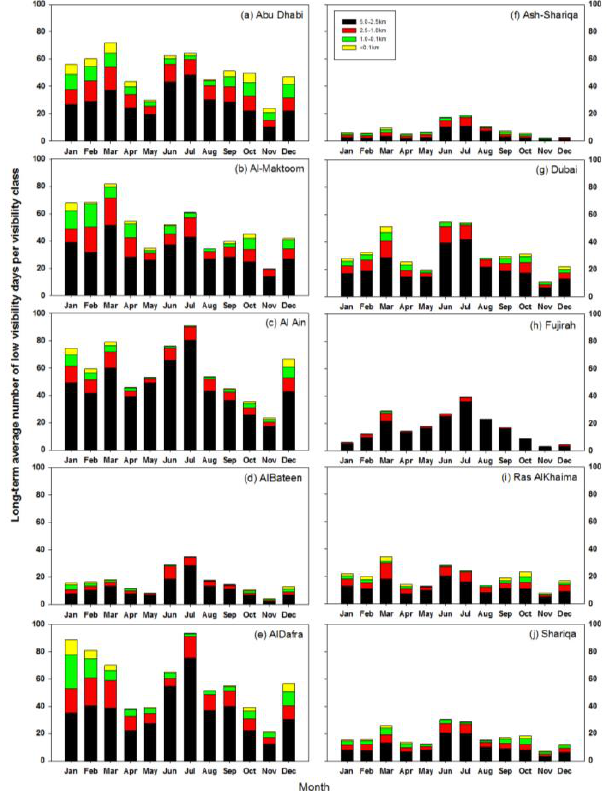
Figure 5. The distribution per month of the number of poor visibility days per class, for the entire record, per station: ( a ) Abu Dhaib, ( b ) Al Maktoom, ( c ) Al Ain, ( d ) AlBateen, ( e ) AlDafra, ( f ) Ash-Shariqa, ( g ) Dubai, ( h ) Fujirah, ( i ) Ras AlKhaima, and ( j ) Shariqa.